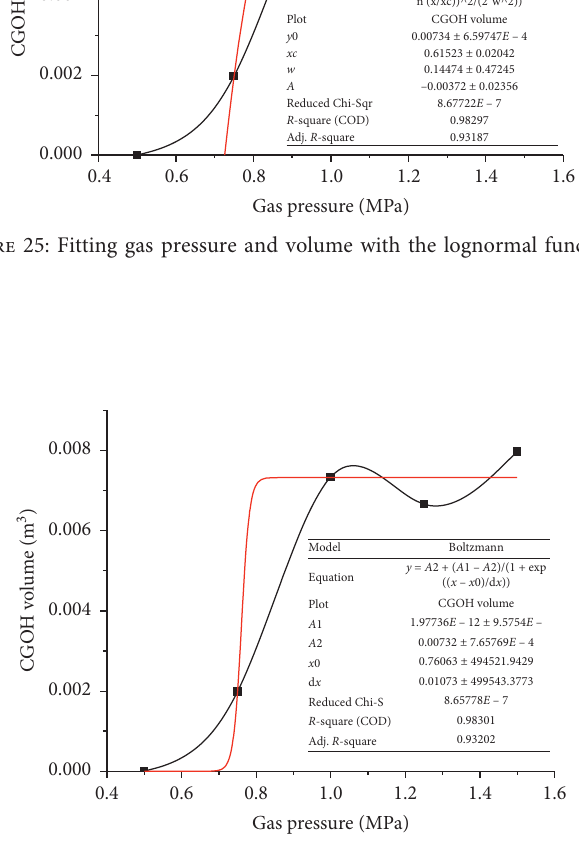
Figure 26: Fitting gas pressure and volume with the Boltzmann